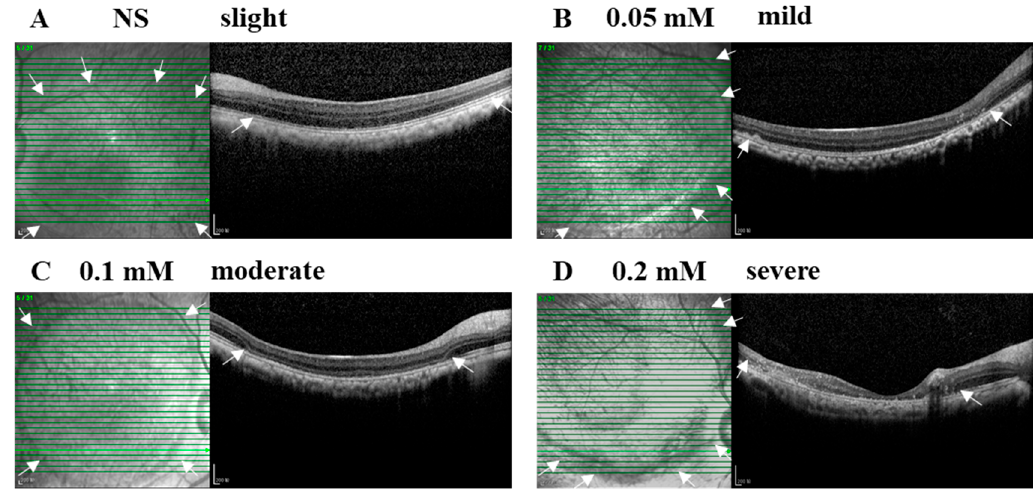
Figure 2. SNP administration induced focal retinal degeneration in monkeys in a dose-dependent manner. ( A–D ) Examples of B-scan (right side) and En-face (left side) SD-OCT images indicate the severity and lesion size of normal saline (NS) and SNP in three doses on day 28 after SI. ( A ) NS caused a slight injury with disorganized photoreceptor segments. ( B ) 0.05 mM led to an uneven mild damage with disorganized photoreceptor segments and partial depletion of the outer nuclear layer at the bleb edge. ( C ) 0.1 mM caused a uniform moderate damage with the depletion of outer retinal layers in the bleb area. ( D ) 0.2 mM caused an uneven severe damage with the whole retina involved in the bleb area. Arrows indicate the edge of the bleb area. Scale bar: 200 μ M.